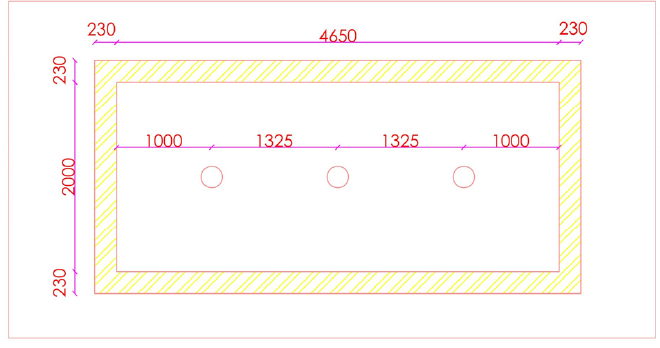
Figure 2. Model tank.